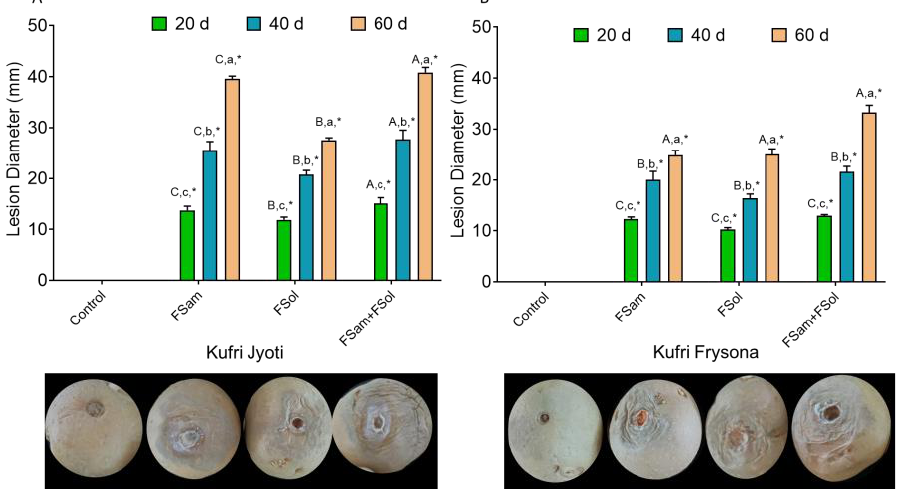
Figure 2. The effect of dry rot infection on lesion diameter on ( A ) Kufri Jyoti ( B ) Kufri Frysona; control, no pathogen infection; FSam, Fusarium sambucinum ; FSol, Fusarium solani ; FSam + FSol, Fusarium sambucinum + Fusarium solani. Capital letter = significance of inoculum (within one date/cultivar combo); Lower case letter = significance of date (within one inoculum/cultivar combo); * = significance between cultivars (within one inoculum/date combo).